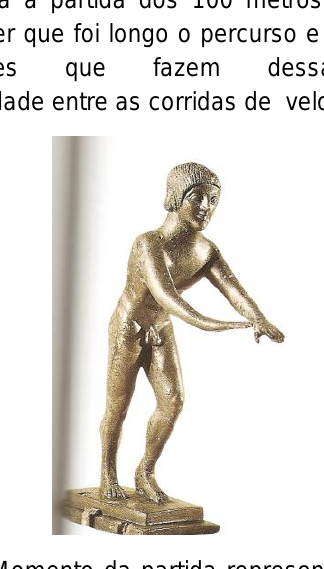
Figura 1- Momento da partida representado pela estatueta de bronze (ANDRONICOS et al, 2004, p. 177).